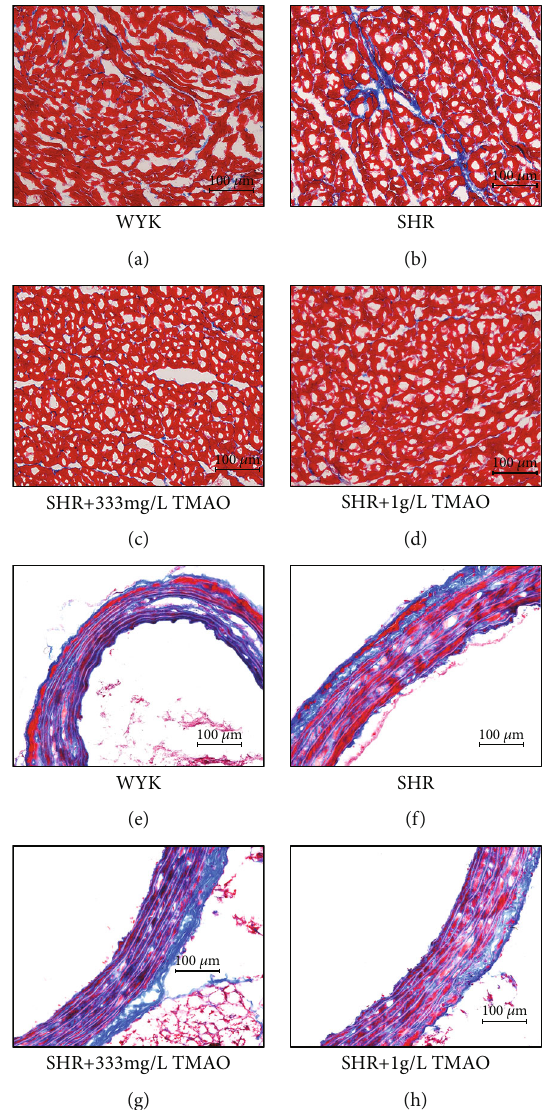
Figure 4: E ff ect of gut microbial-related choline metabolite TMAO on histopathology of the heart and arteries. Masson staining of the left ventricular tissue from the above (a) Wistar-Kyoto (WKY) rats, (b) spontaneously hypertensive rats (SHRs) treated with water, and SHRs treated with water containing (c) 333 mg/L and (d) 1 g/L TMAO. Masson staining of aorta from (e) WKY rats, (f) SHRs treated with water, and SHRs treated with water containing (g) 333 mg/L and (h) 1g/L